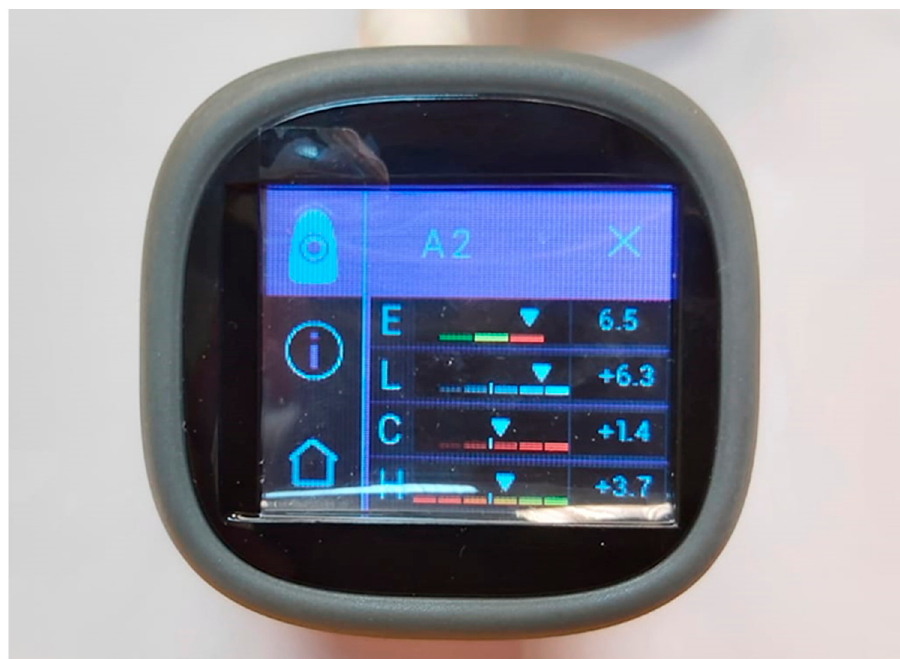
Figure 3. The panel of spectrophotometer showing Δ E value.